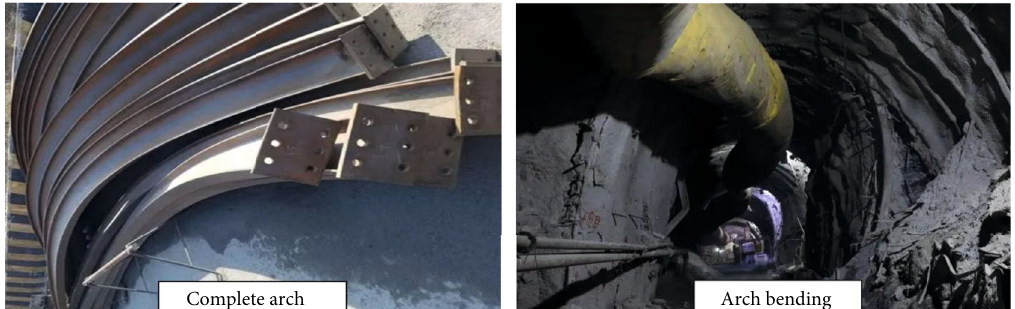
Figure 13: Internal force of arch frame and deformation of arch foot.